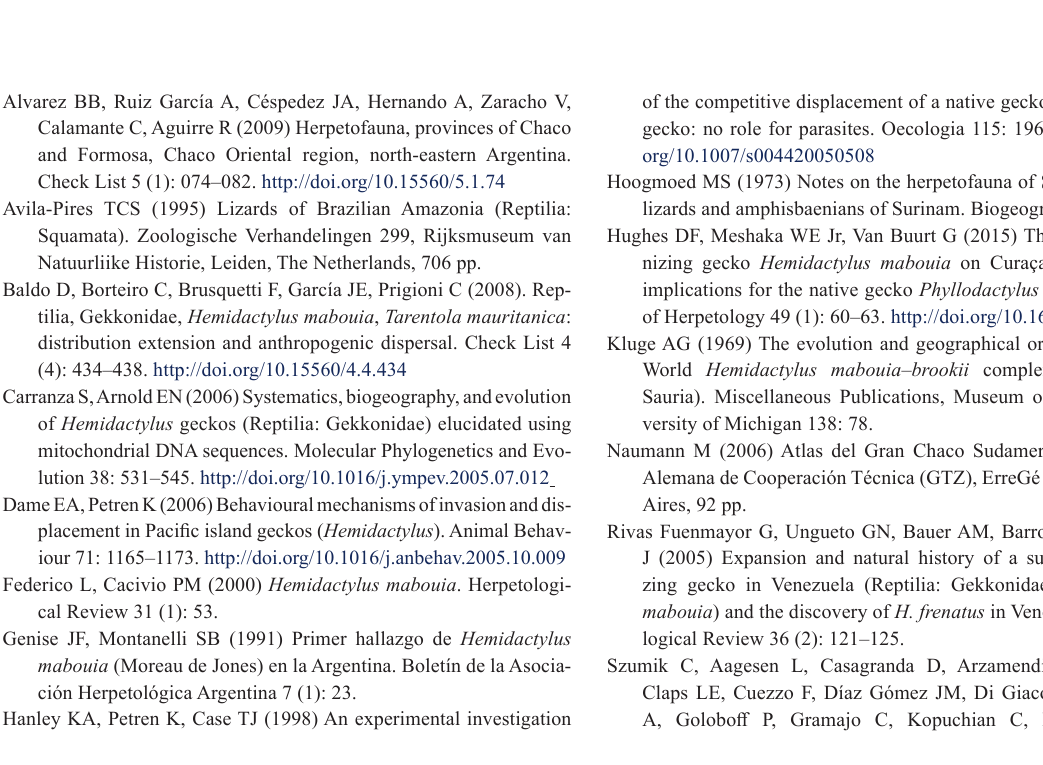
Figure 2. Specimens of H. mabouia LGE 20047. A. Dorsal view of the body. Scale bar = 5 mm. B. Distance of the lamellae from the base of the foot. C. Lateral view of the head. Scale bar = 1